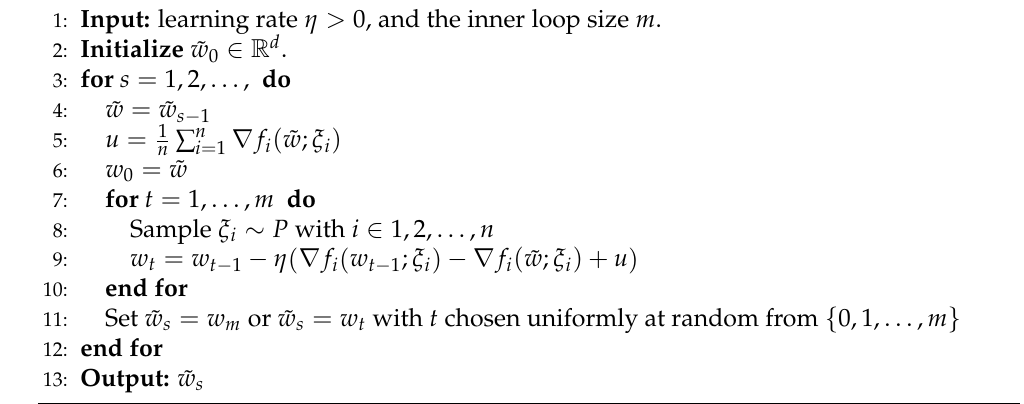
Algorithm 4 Stochastic variance reduced gradient (SVRG)